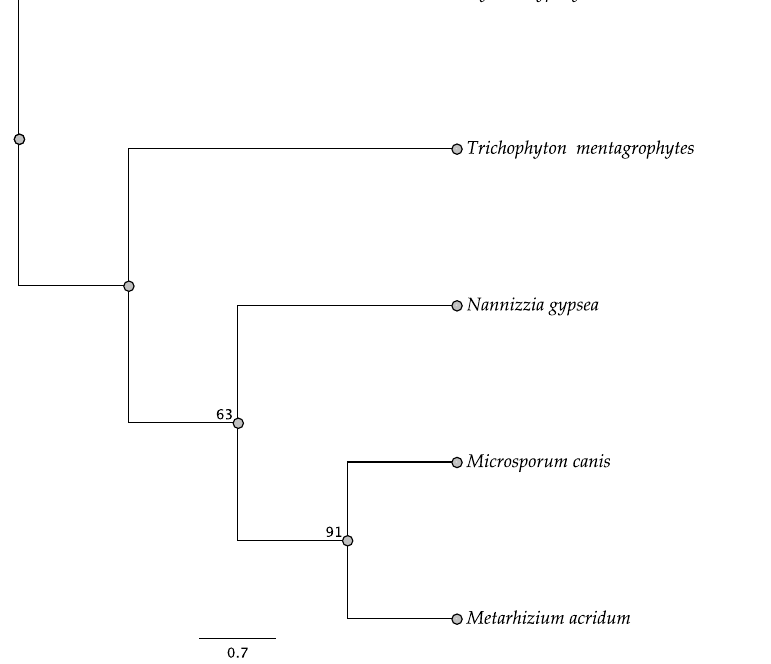
Figure 14. Maximum parsimony DNA tree resulting from the analysis of the swnT – swnN intergenic region sequence data. Bootstrap confidence values from 1000 bootstrap replicates are presented at each corresponding node. Fungal orders are indicated next to each organism/clade.